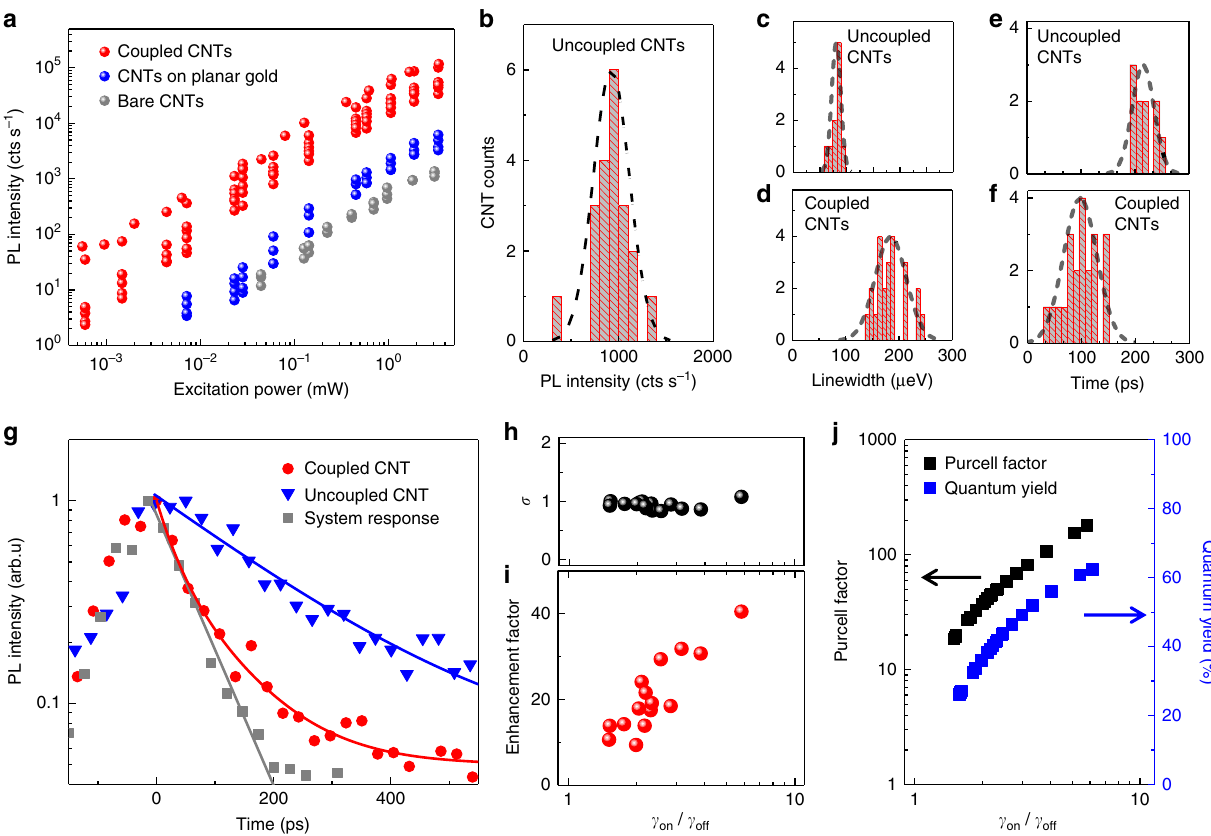
Fig. 4 Quantifying SE enhancement of the E 11 exciton emission. a Integrated PL intensity of the E 11 zero-phonon line (ZPL) as a function of excitation power. Red circles are data for coupled SWCNTs, blue circles for reference SWCNTs (off-cavity), and gray circles for bare SWCNTs on Si/SiO 2 substrate. b Histogram of ZPL peak intensity for 20 reference SWCNTs recorded at fi xed excitation power of 0.6 mW. c , d , Histogram of Lorentzian full width half maximum (FWHM) values of the E 11 ZPL for 10 reference SWCNTs ( c ) and 21 coupled SWCNTs ( d ). e , f Histogram of lifetimes for 10 reference SWCNTs ( e ) and 21 coupled SWCNTs ( f ). Raw data are shown in Supplementary Note 6. g Temporal dynamics of E 11 exciton emission recorded by TCSPC at 200 μ W excitation power. Gray squares: System response for back-re fl ected laser light. Solid gray line: Mono-exponential fi t representing the system response. Blue triangles are data for a reference SWCNT and the solid blue line is a deconvolved fi t which yields a mono-exponential decay time of τ off = 248 ± 3 ps. The red circles are data from a coupled SWCNT and yield τ on = 37 ± 3 ps (red solid line). h Ratio σ representing the total rate enhancement factor ( γ on / γ off ) determined from the time-integrated approach divided by γ on / γ off measured directly via time-correlated single photon counting (TCSPC). The strong correlation, σ ~ 1, indicates that both techniques determine the same physical quantity. i Correlation between intensity enhancement factor (EF) and γ on / γ off from TCSPC, which indicates dominant radiative recombination. j Underlying Purcell factor (black square) and quantum yield (blue square) as a function of measured γ on / γ off . All data are recorded at 3.8